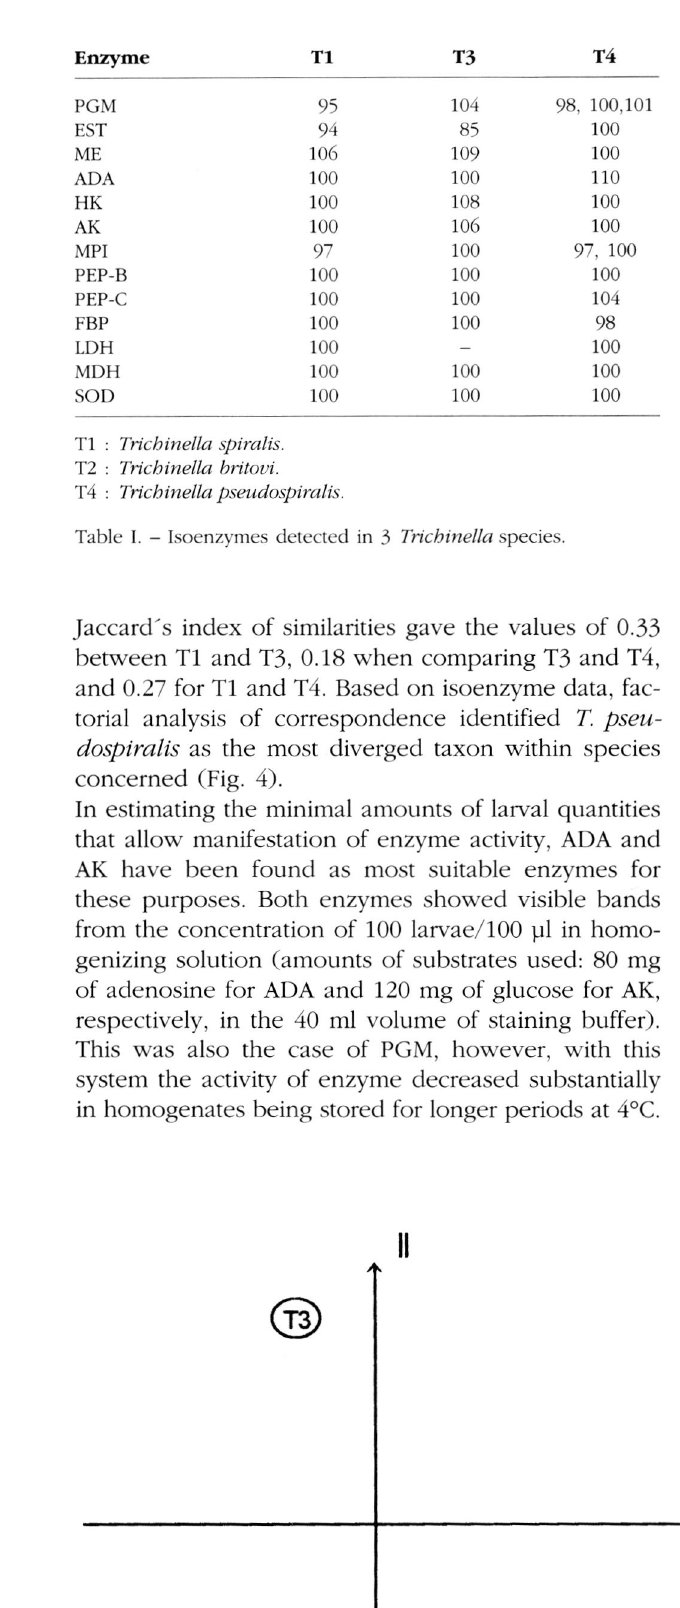
Fig. 4. - Horizontal axis explaining 58 % of the total variance, vertical axis explaining 42 % of the total variance. T 4 was placed in the most distinct posi tion along axis 1.